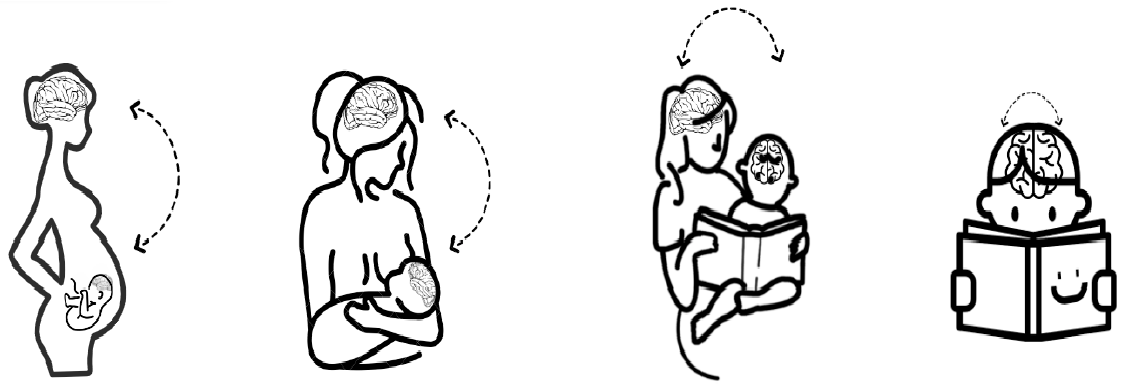
Figure 2. Suggested developmental progress of synchronization between the mother and child from pregnancy to reading